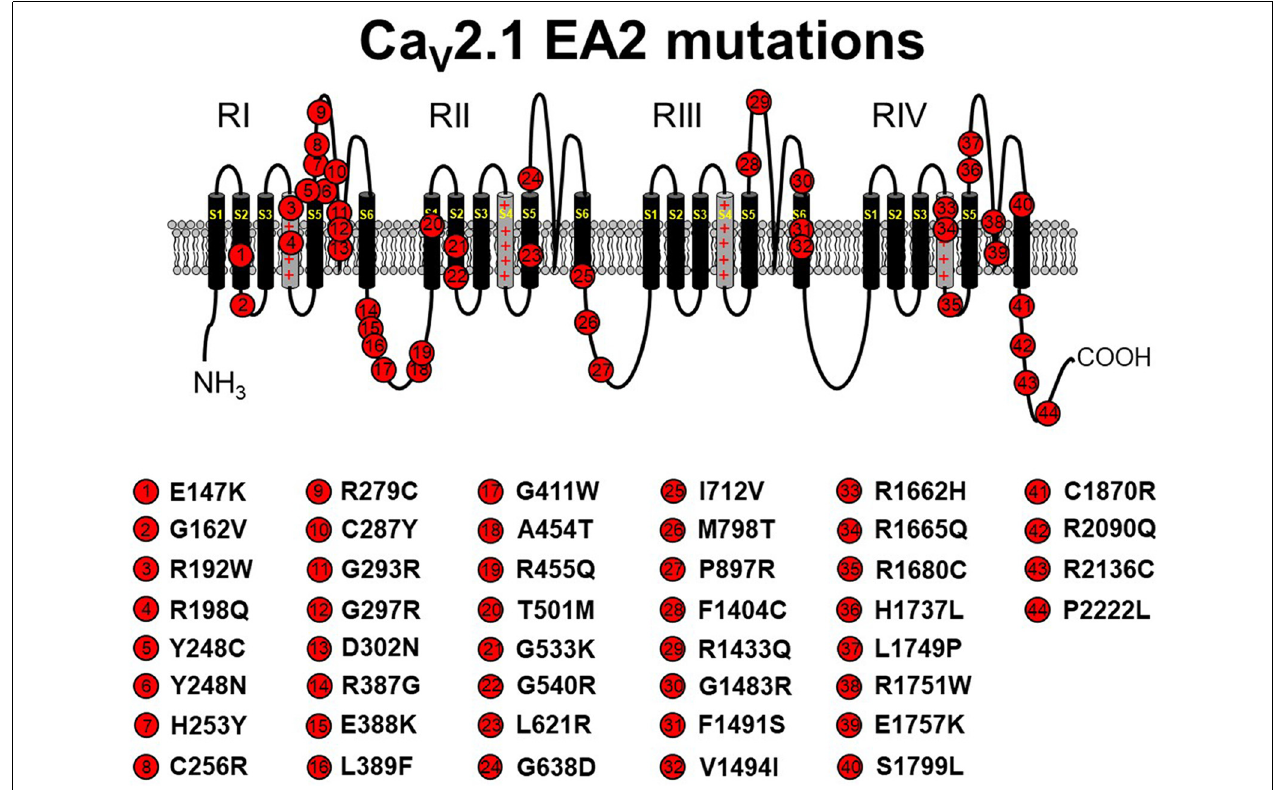
FIGURE 1 | Schematic representation of human Ca V 2.1 mutations causing episodic ataxia type 2 (EA2). Please note that residue numbering varies between studies due to the existence of multiple CACNA1A splice variants; residue numbers indicated reflect those stated in the original report. Citations to the indicated